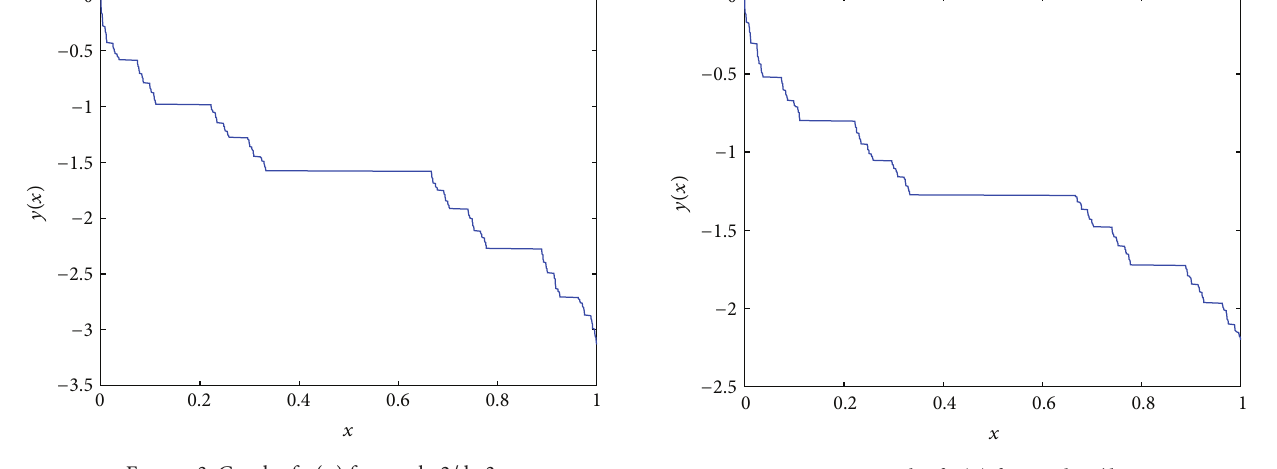
Figure 3: Graph of 𝑦(𝑥) for 𝛼 = ln 2/ ln 3 . Figure 4: Graph of 𝑦(𝑥) for 𝛼 = ln 2/ ln 3